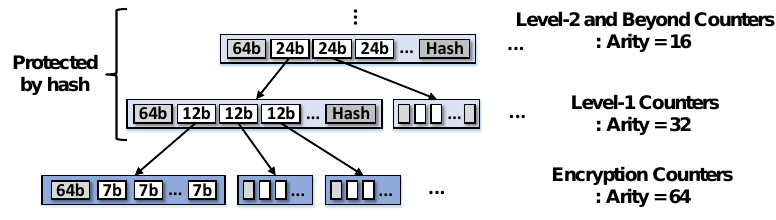
Figure 3. The tree structure of VAULT